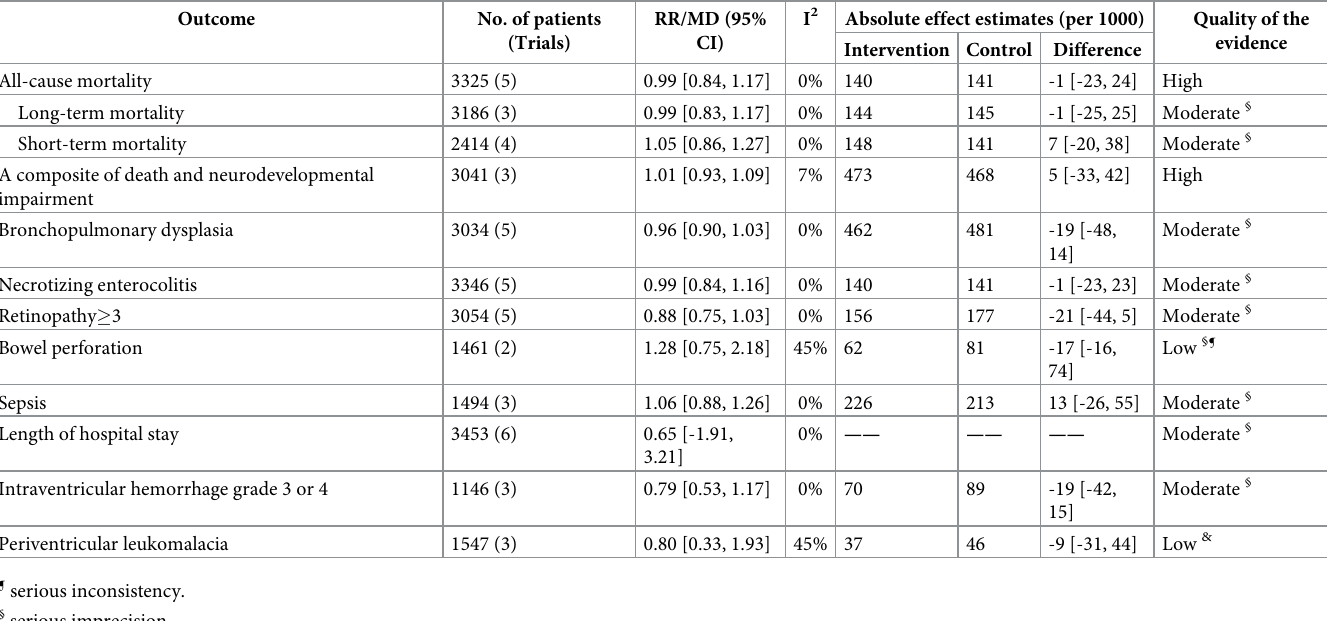
Table 2. Summary of findings and strength of evidence of